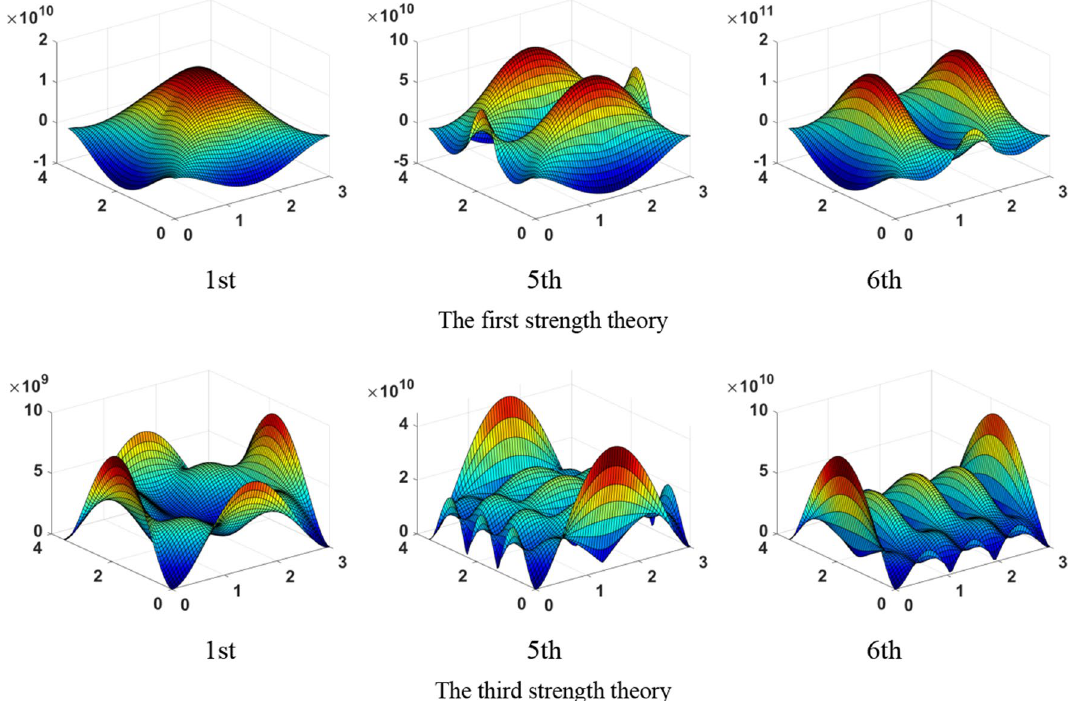
Figure 9. The maximum shear stress(τ max ) distribution of the 1st, 5th and 6th mode.